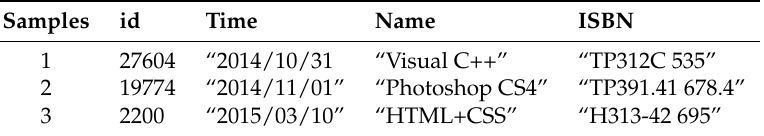
Table 2. Samples of the books lending data.